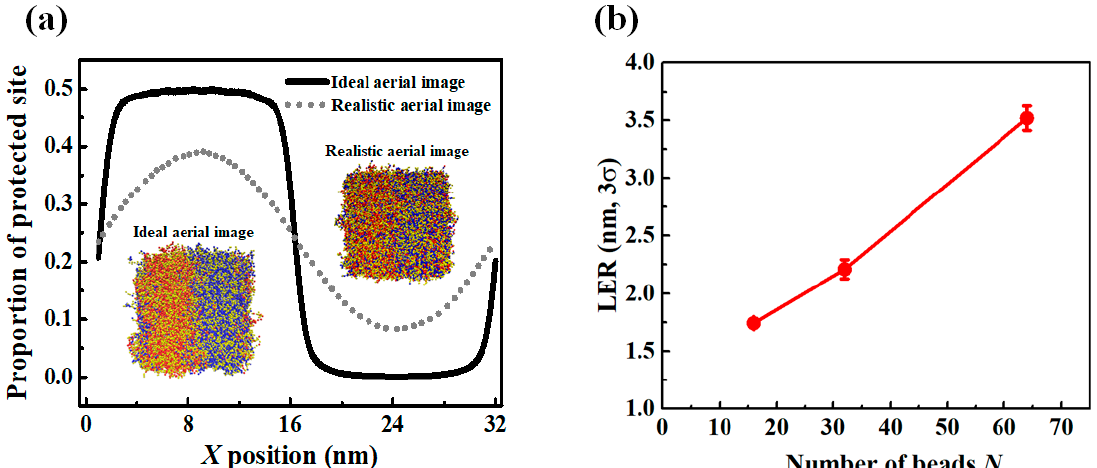
Figure 8. ( a ) Density profile of protected site. The inset shows a snapshot of simulations after exposure step. Left side and right side of inset represent ideal aerial image case and realistic aerial image case, respectively. ( b ) LER values of CAR for high T g as a function of N where 90% contrast image exists with fixed f p = 0.5.